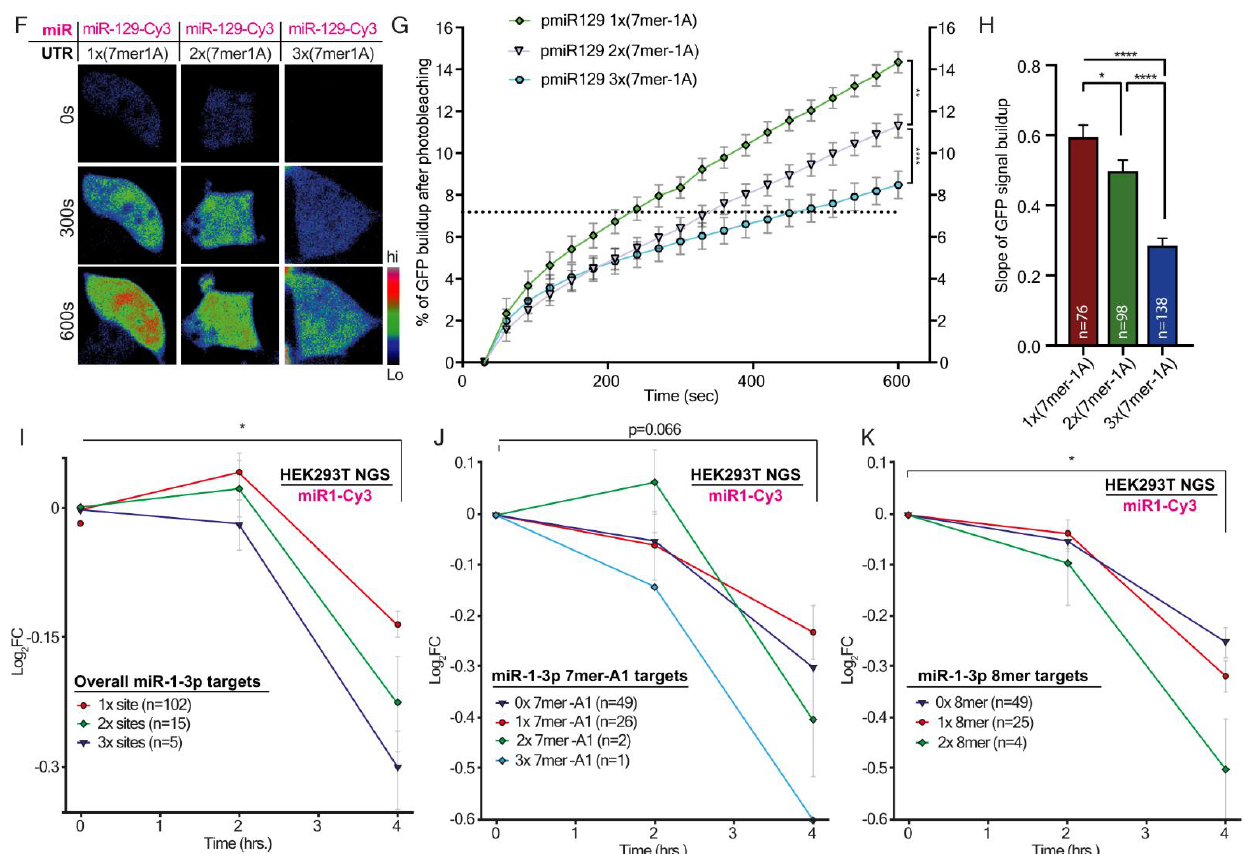
Figure 6. The number of miR-129-5p binding sites differentially regulates the 3 (cid:48) UTR variants of Kif5b and dGFP. ( A ) A schematic illustration of the experimental setup. The 3 (cid:48) UTR of dGFP was replaced with the 3 (cid:48) UTR of either short or long isoforms of Kif5b. Green indicates dGFP coding sequence (CDS). Light and dark blue indicate short and long 3 (cid:48) UTRs Kif5b, respectively. Nucleotides labeled with grey do not complement the mature miR-129-5p sequence. Nucleotides labeled with yellow represent the 7mer-A1 target sequence for miR-129-5p seed. Nucleotides labeled in pink are part of mature miR- 129-5p ( B ) Representative images of dGFP in 293T cells carrying short or long 3 (cid:48) UTR of Kif5b, fused to dGFP co-transfected with mature miR-129-5p. Three time points are shown for each cell: 0 min, 5 min, and 10 min after photobleaching. ( C ) The graph shows the cumulative percent of fluorescence of dGFP during the 10 min following photobleaching. ** p -value < 0.01. ( D ) Quantification of the mean slope of dGFP signal build-up after photobleaching. *** p -value < 0. 001. ( E ) A schematic illustration of the experimental setup. The 3 (cid:48) UTR of dGFP was modified to contain 1X, 2X, or 3X 7mer-A1 target sites for miR-129-5p. Green indicates the dGFP coding sequence (CDS). Light magenta indicates the unmodified 3 (cid:48) UTR of dGFP. Nucleotides labeled with grey do not complement the mature miR-129-5p sequence. Nucleotides labeled with yellow represent the 7mer-A1 target sequence for miR-129-5p seed. Nucleotides labeled in pink are part of mature miR-129-5p ( F ) Representative images of dGFP in 293T cells carrying single, double, or triple miR-129-5p binding sites in the 3 (cid:48) UTR of dGFP co-transfected with mature miR-129-5p. The images show three time points for each cell: 0 min, 5 min, and 10 min after photobleaching. ( G ) The graph shows the cumulative percent of fluorescence of dGFP during the 10 min following photobleaching. ** p -value < 0.01, **** p -value < 0.0001 ( H ) Quantification of the mean slope of dGFP signal build-up after photobleaching. Ordinary one-way ANOVA **** p < 0.0001. Post-hoc multiple comparisons: * p -value < 0.05, **** p -value < 0.0001. ( I – K ) NGS quantification of the transcript levels of the miR-1-3p targets categorized by the ( I ) overall number of sites, * p -value < 0.05, ( J ) the number of 7mer-A1 sites, and ( K ) 8mer binding sites for miR-1-3p at 0 h, 2 h, and 4 h after miR-1-3p transfection into 293T cells. * p -value <